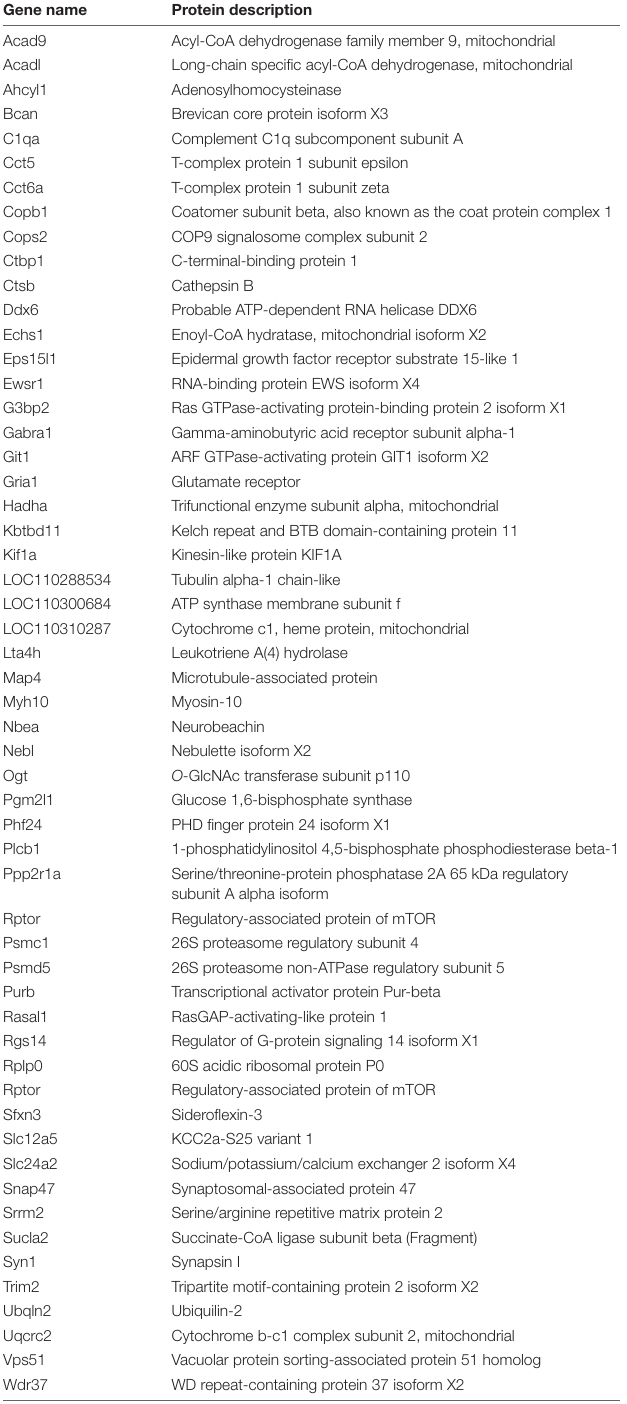
TABLE 1 | Differential interactive proteins of Rer1 in the hippocampus of PTZ-induced Nedd4-2 + / −